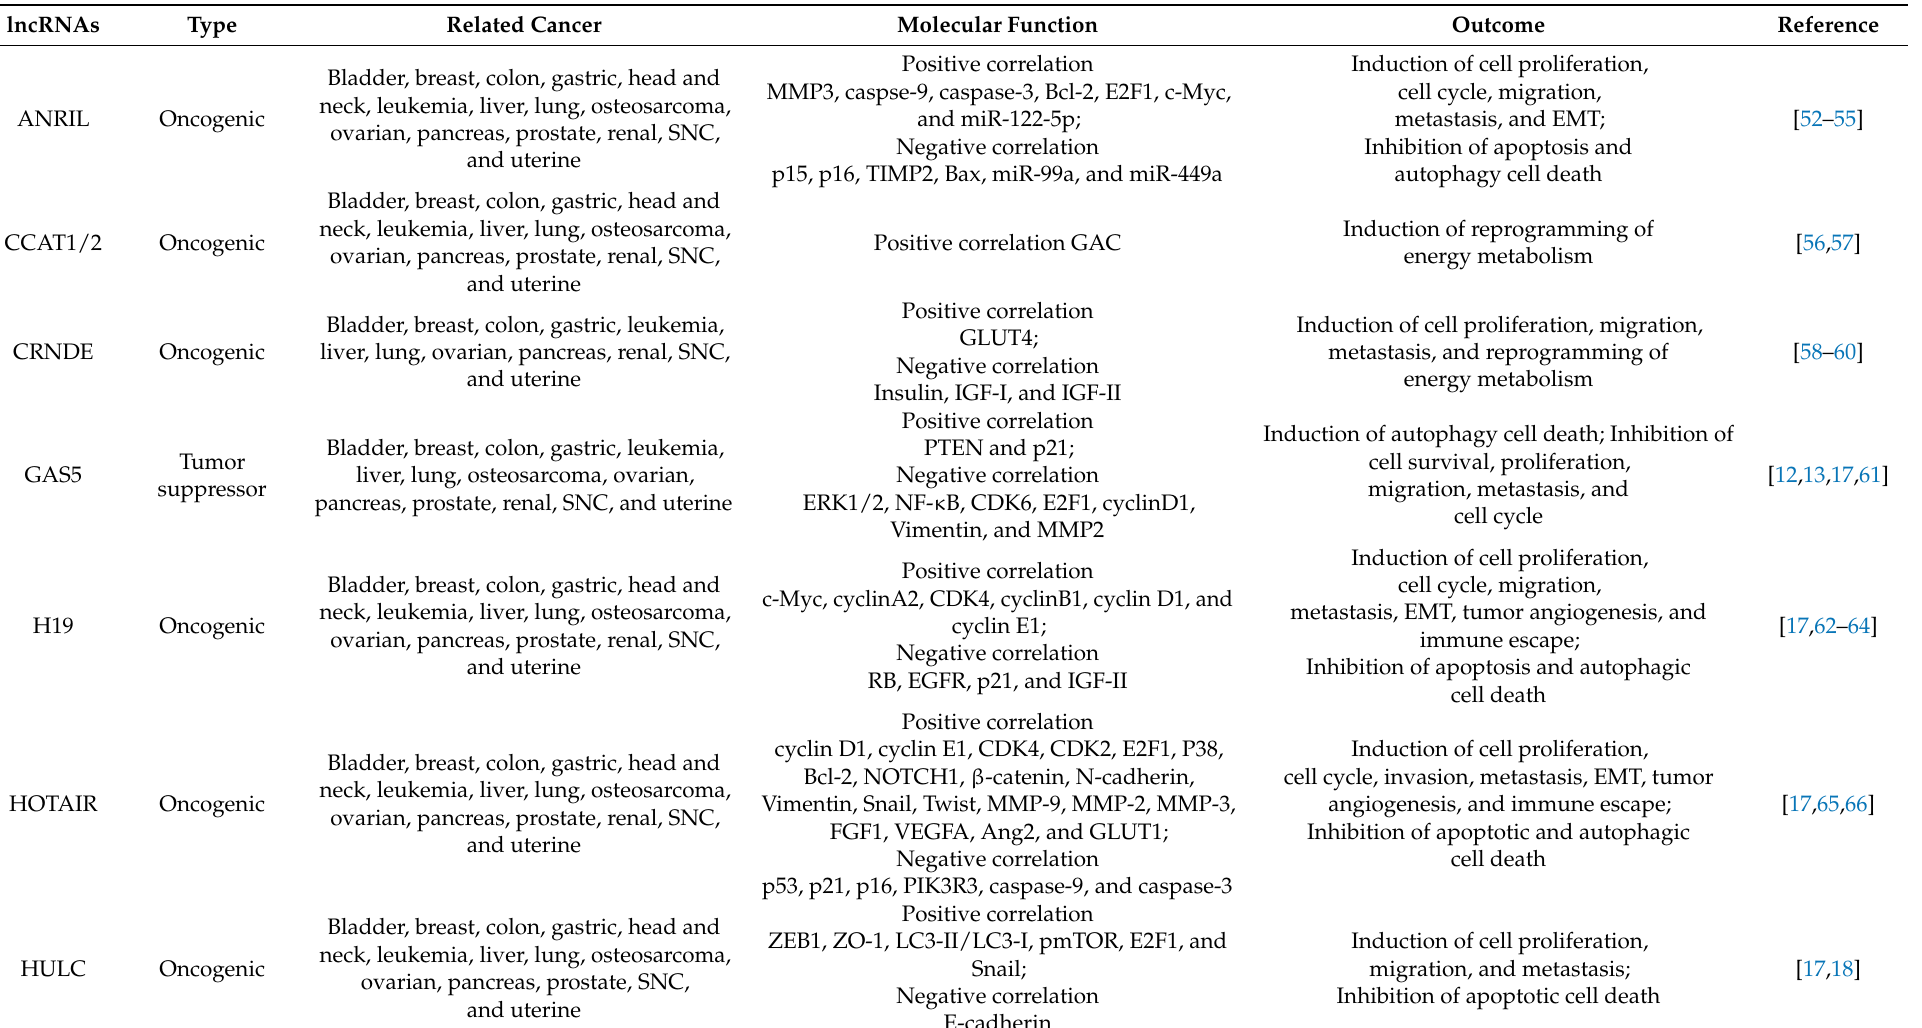
Table 1. Summary of various well-known cancer-related lncRNAs, their molecular functions, and cellular